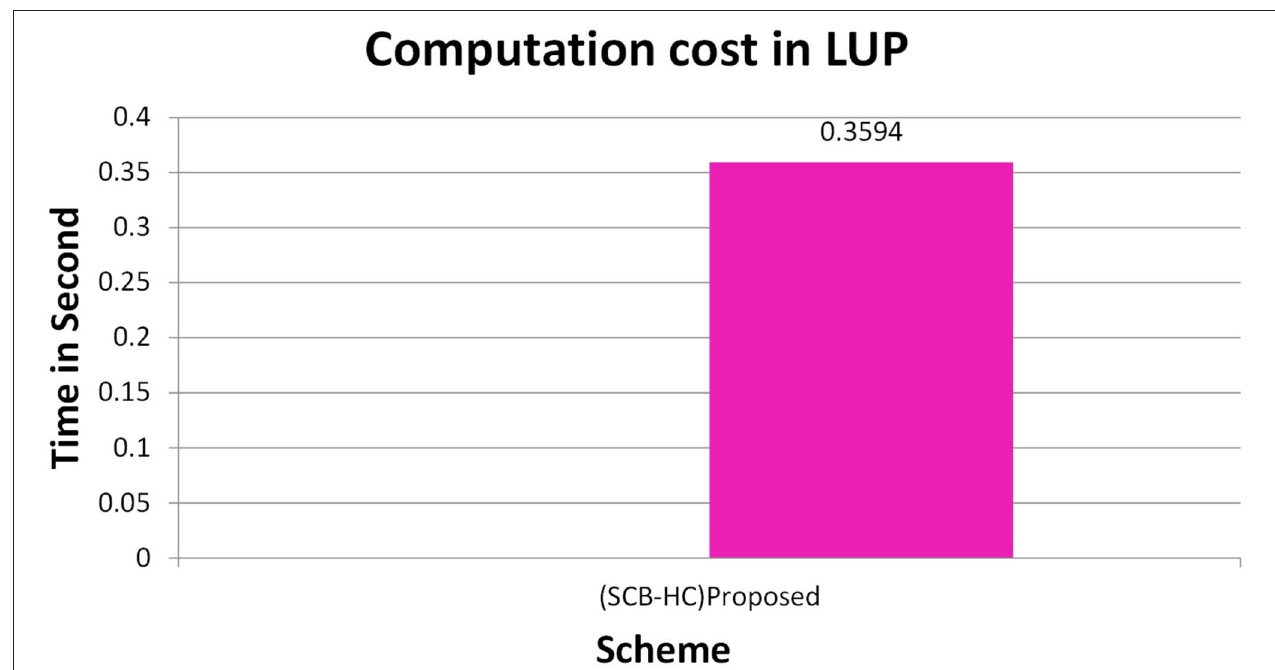
FIGURE 5 | LUP computation